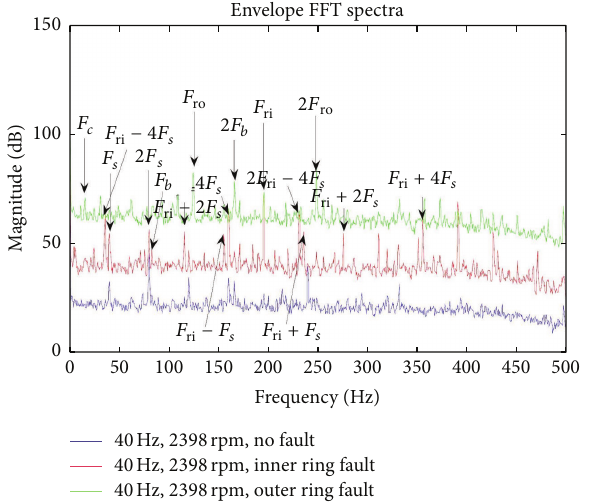
Figure 9: Inner defect spectra of 50 Hz motor input, different load conditions (free load, fan load, and pump load), and radial vibration